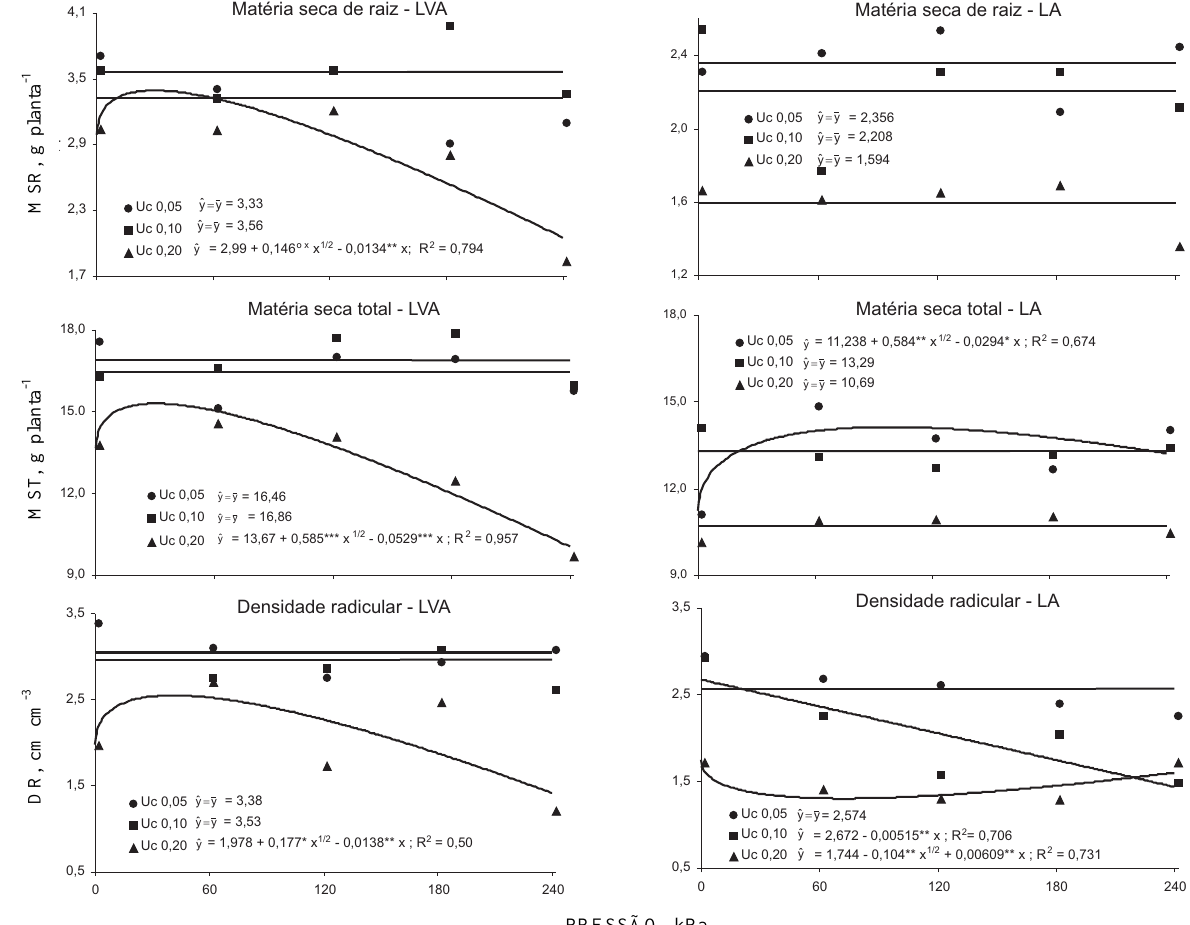
Figura 2. Densidade radicular, matéria seca de raiz e total de eucalipto em dois Latossolos compactados com diferentes pressões e